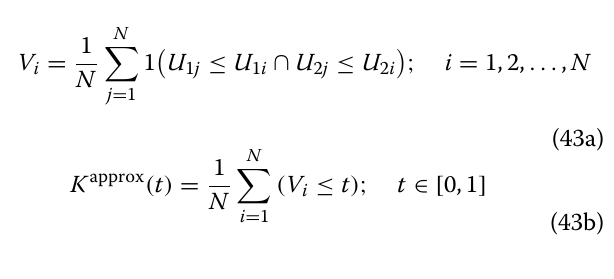
Figure 2 compares the marginal variables computed using Eq. (41) from the MECC with both empirical and POME- based univariate marginals. As seen in Fig. 2, C ( u ,1) and